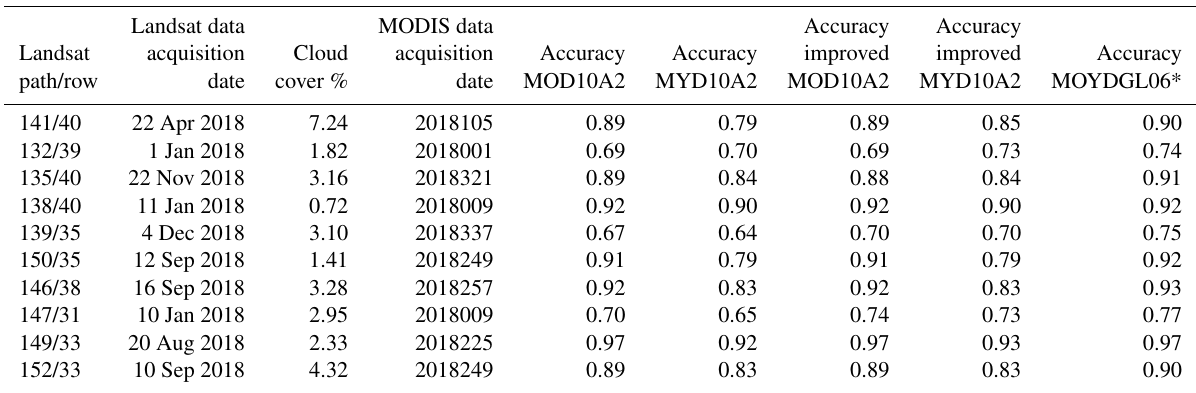
Table 2. Validation of snow cover (minimum snow cover period) for 10 selected well-distributed areas to represent the study area derived by the original Terra MODIS (MOD10A2.006*), Aqua MODIS (MYD10A2.006*), and their individual and merged improved